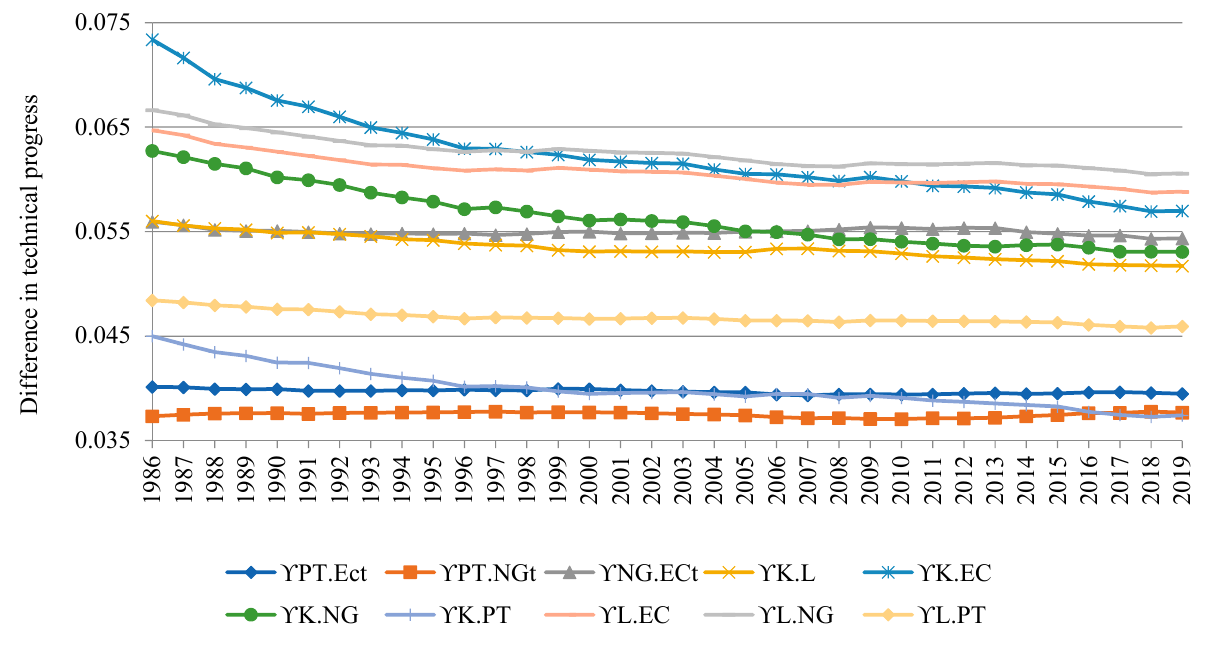
Figure 4. Technical progress among the input pairs of factors from 1986–2019.